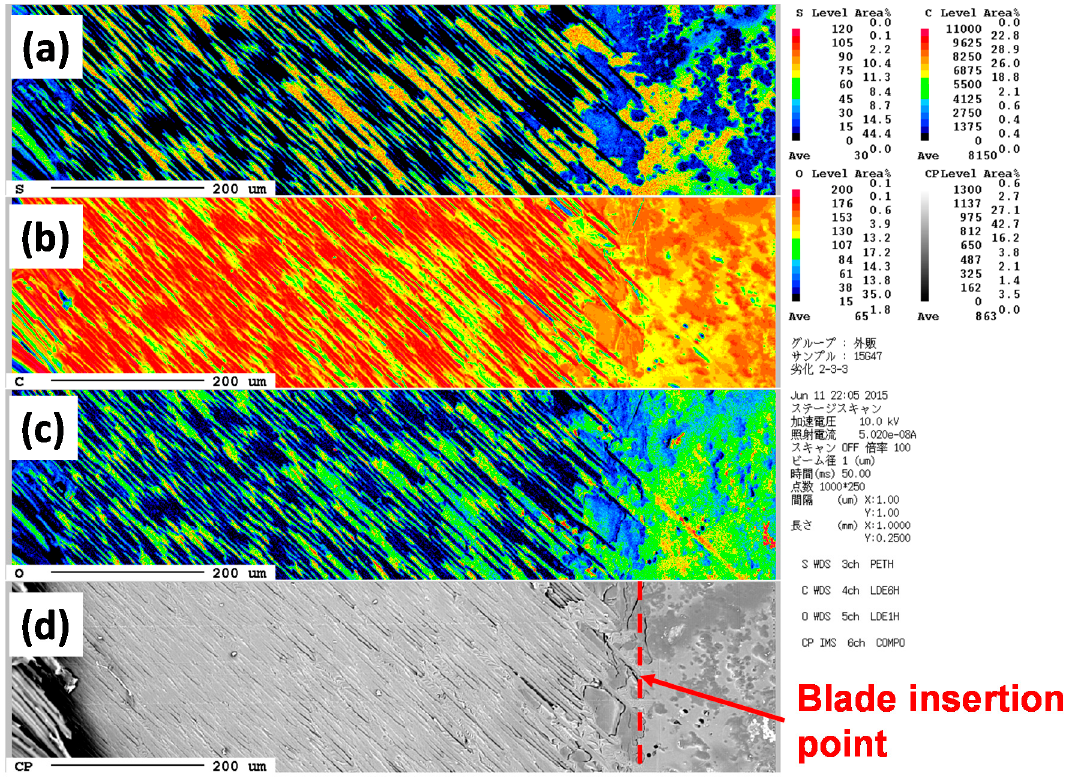
Figure 17. EPMA mapping of degraded CFRP sample (160 °C in 14 days with moisture) for sulfur ( a ), carbon ( b ) and oxygen atoms ( c ). Image ( d ) shows the SEM image with the marked measurement position.